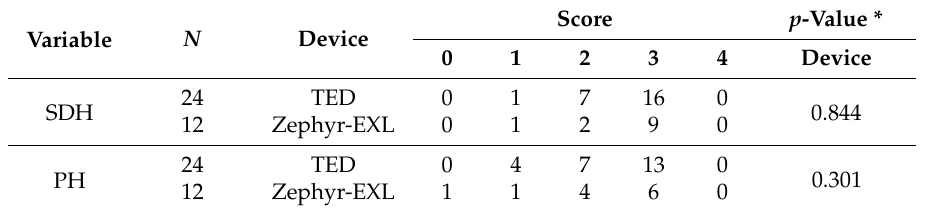
Table 8. Distribution of microscopic hemorrhage scores following application of the Turkey Euthanasia Device (TED) and Zephyr-EXL.